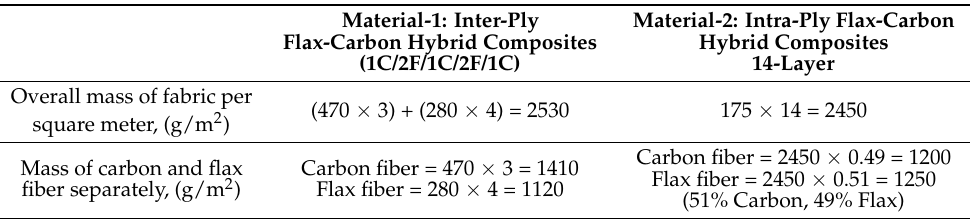
Table 2. Amount of carbon and flax fiber present in inter-ply and intra-ply hybrid composites. Material-1: Inter-Ply Flax-Carbon Hybrid